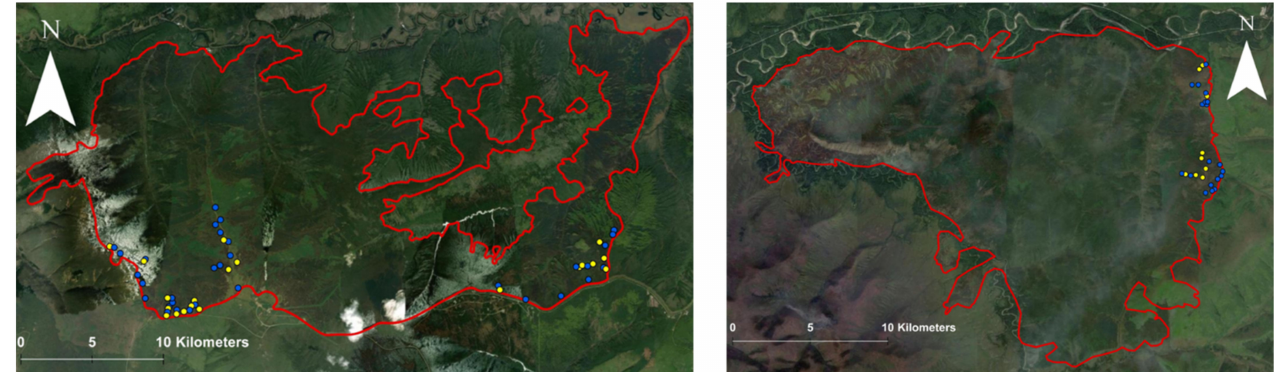
Figure 2. The 52 CBI plots (yellow = training; blue = non-training) surveyed within the Shovel Creek burn scar ( left ); and the 28 CBI plots surveyed within the Nugget Creek burn scar ( right ) (red: burn scar